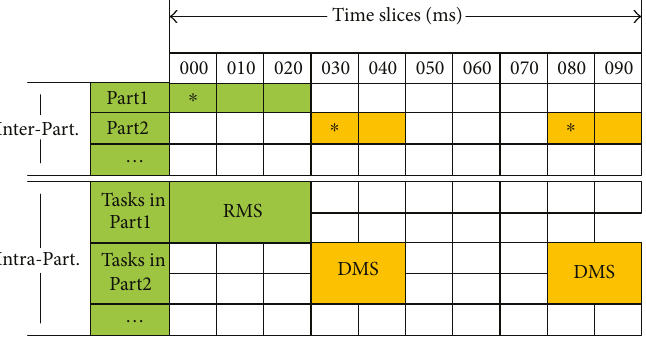
Figure 14: REAL theorems of health monitoring.